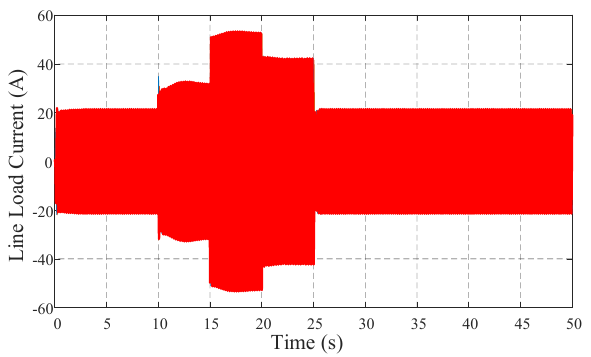
Figure 20. Load current.